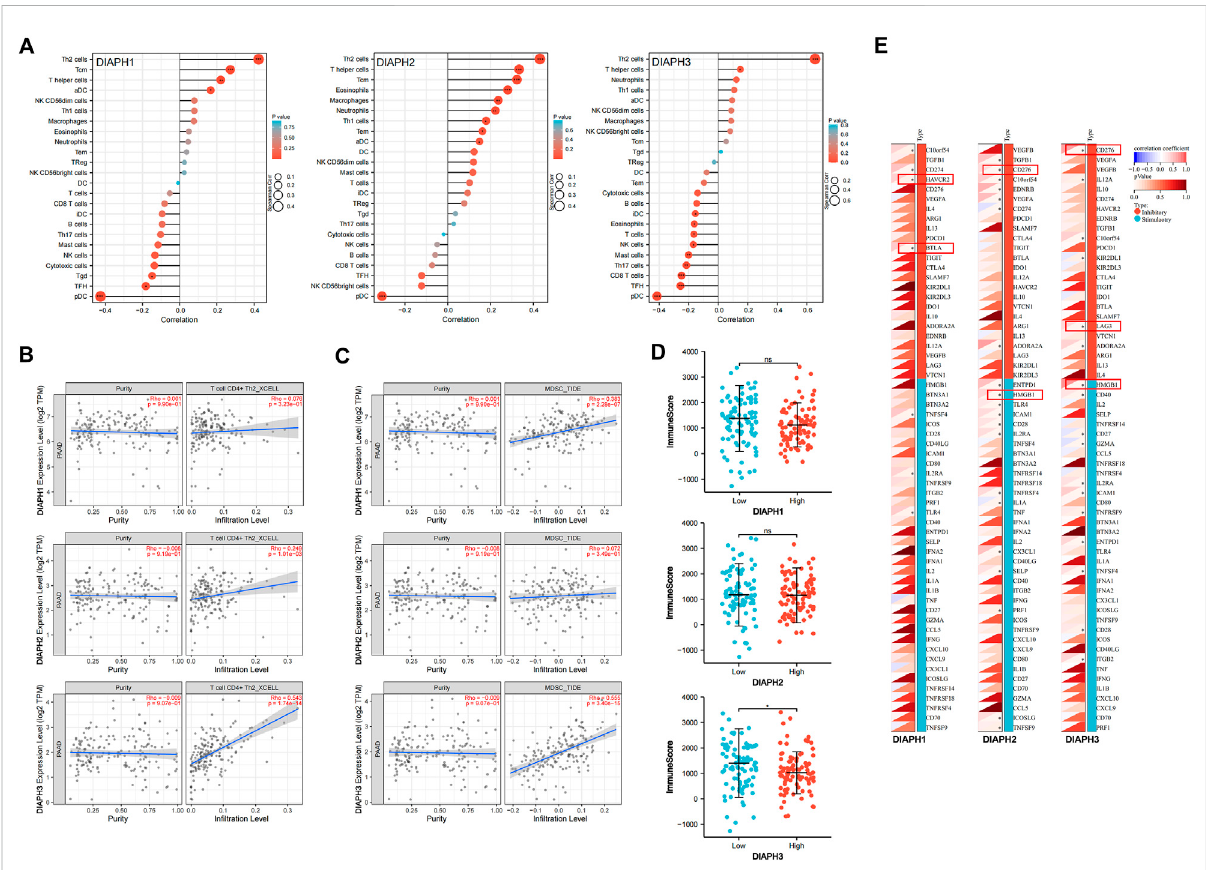
FIGURE 8 ImmunereactivityanalysisofDIAPHsinPAADofTCGAdatabase. (A) ThecorrelationbetweenDIAPHsexpressionandin fi ltrationof24common immune cells in PAAD by ssGSEA. * p < 0.05, ** p < 0.01, *** p < 0.001, in Spearman ’ s rho. (B) The correlation between DIAPHs expression and in fi ltration of CD4 + Th2 cells with xCell algorithm in PAAD, in purity-adjusted Spearman ’ s rho. (C) The correlation between DIAPHs expression and in fi ltration of MDSCs with TIDE algorithm in PAAD, in purity-adjusted Spearman ’ s rho. (D) ImmunoScore between high- and low-expression groups based on the median expression values of DIAPHs in PAAD. * p < 0.05, in Wilcoxon test. (E) The correlation analysis of the DIAPHs expression and immune checkpoints expression in PAAD. * p < 0.05, in Pearson ’ s correlation coef fi